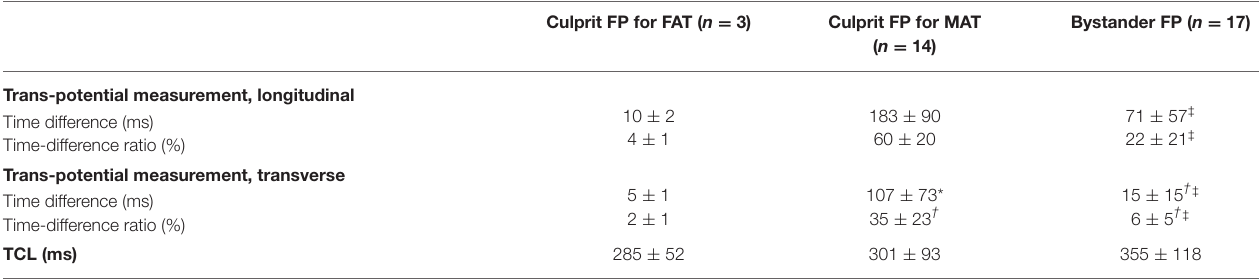
TABLE 3 | Cross-mapping measurement around fractionated potentials with different